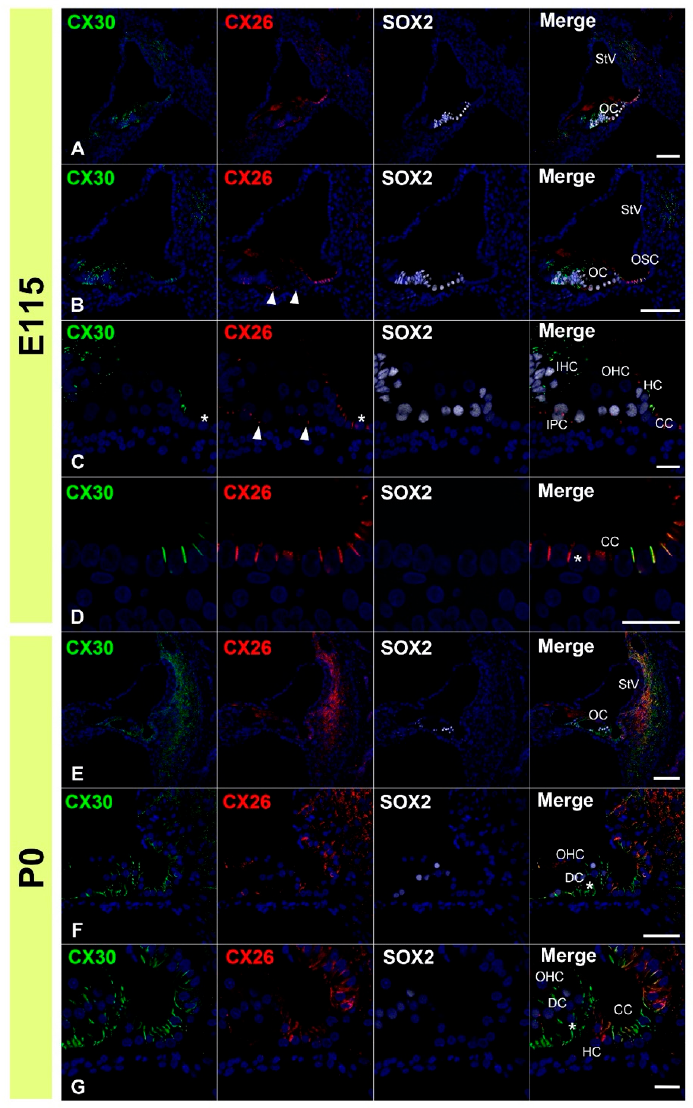
Figure 6. Comparison of the expression patterns of CX26 and CX30 at E115 and P0. ( A – D ) At E115, only CX26 expression was detected on the basal side of supporting cells of the organ of Corti (arrowheads in ( B , C )). In Hensen’s cells, both CX26 and CX30 expressions were detected on the cells’ upper side. On the modiolus side of Claudius’ cells, only CX26 expression was detected (asterisks in ( C , D )). ( E – G ) At P0, both CX26 and CX30 expressions were detected from the outer sulcus cells to the inner sulcus cells except for the inner and outer hair cells. However, in the organ of Corti, a relatively high expression of CX30 was observed (asterisk in ( G )). SOX2 was used to label supporting cells. Nuclei were counterstained with Hoechst stain (blue). Scale bar: 100 µm in ( A , B , E ), 50 µm in ( F ), 20 µm in ( C , D , G ). StV: stria vascularis, OC: organ of Corti, OSC: outer sulcus cells, IHC: inner hair cells, OHC: outer hair cells, CC: Claudius’ cells, HC: Hensen’s cells, IPC: inner pillar cells, DC: Deiters’ cells. ( A – G ): basal turn.